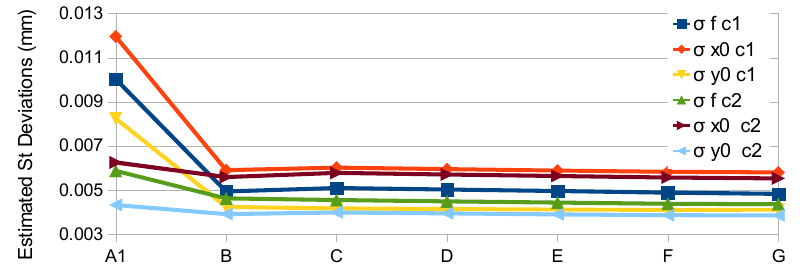
and y for both 0 0